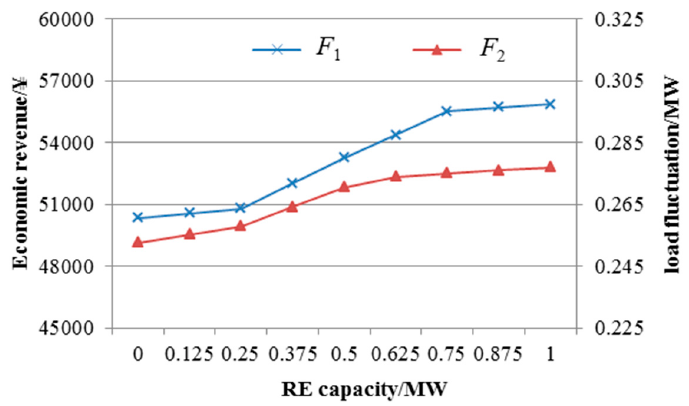
Figure 13. Objective values of HES operation with various RE capacities.